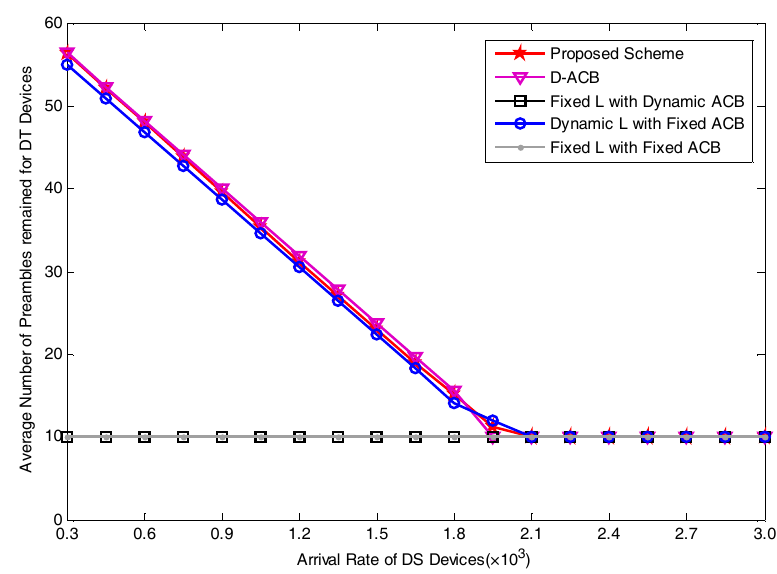
Figure 11. Average Number of Preambles for Pool 2 for varying arrival rates.